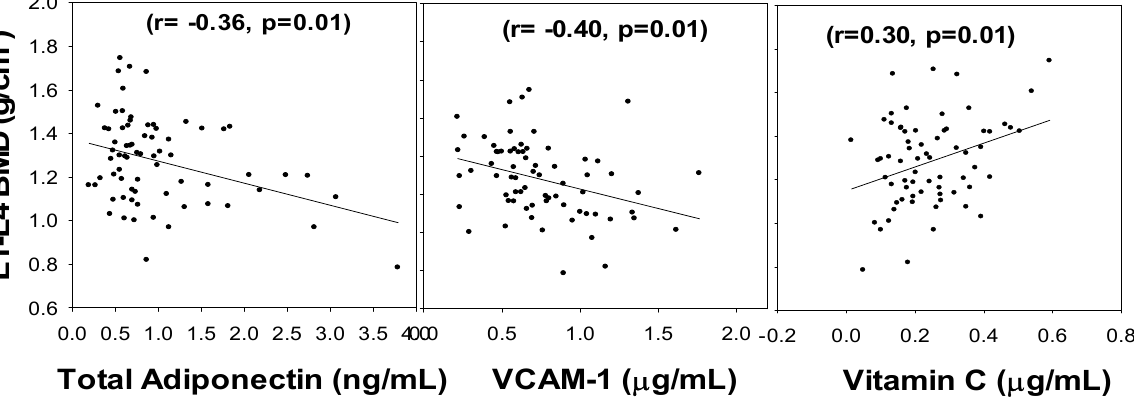
Figure 1. Correlation of Lumbar spine BMD with blood levels of total adiponectin, VCAM-1, and vitamin C in subjects with diabetes. P -values were determined using multiple regression analyses and controlling for BMI and duration of diabetes.